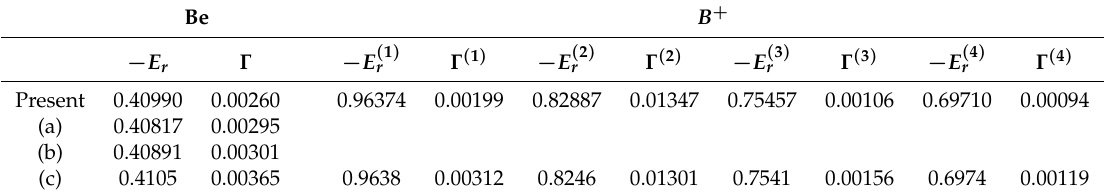
Table 3. Energies (in a.u.) and widths (in a.u.) of the doubly-excited states (DESs) of Be-like ions for λ = 0 lying above the 1 s 2 2 p threshold. Energies were measured relative to the energy of the corresponding core. Rows (a), (b) and (c) correspond to the results of Refs. [16,26,27], respectively. Be B + − E r Γ − E ( 1 ) r Γ ( 1 ) − E ( 2 ) r Γ ( 2 ) − E ( 3 ) r Γ ( 3 ) − E ( 4 ) r Γ ( 4 ) Present 0.40990 0.00260 0.96374 0.00199 0.82887 0.01347 0.75457 0.00106 0.69710